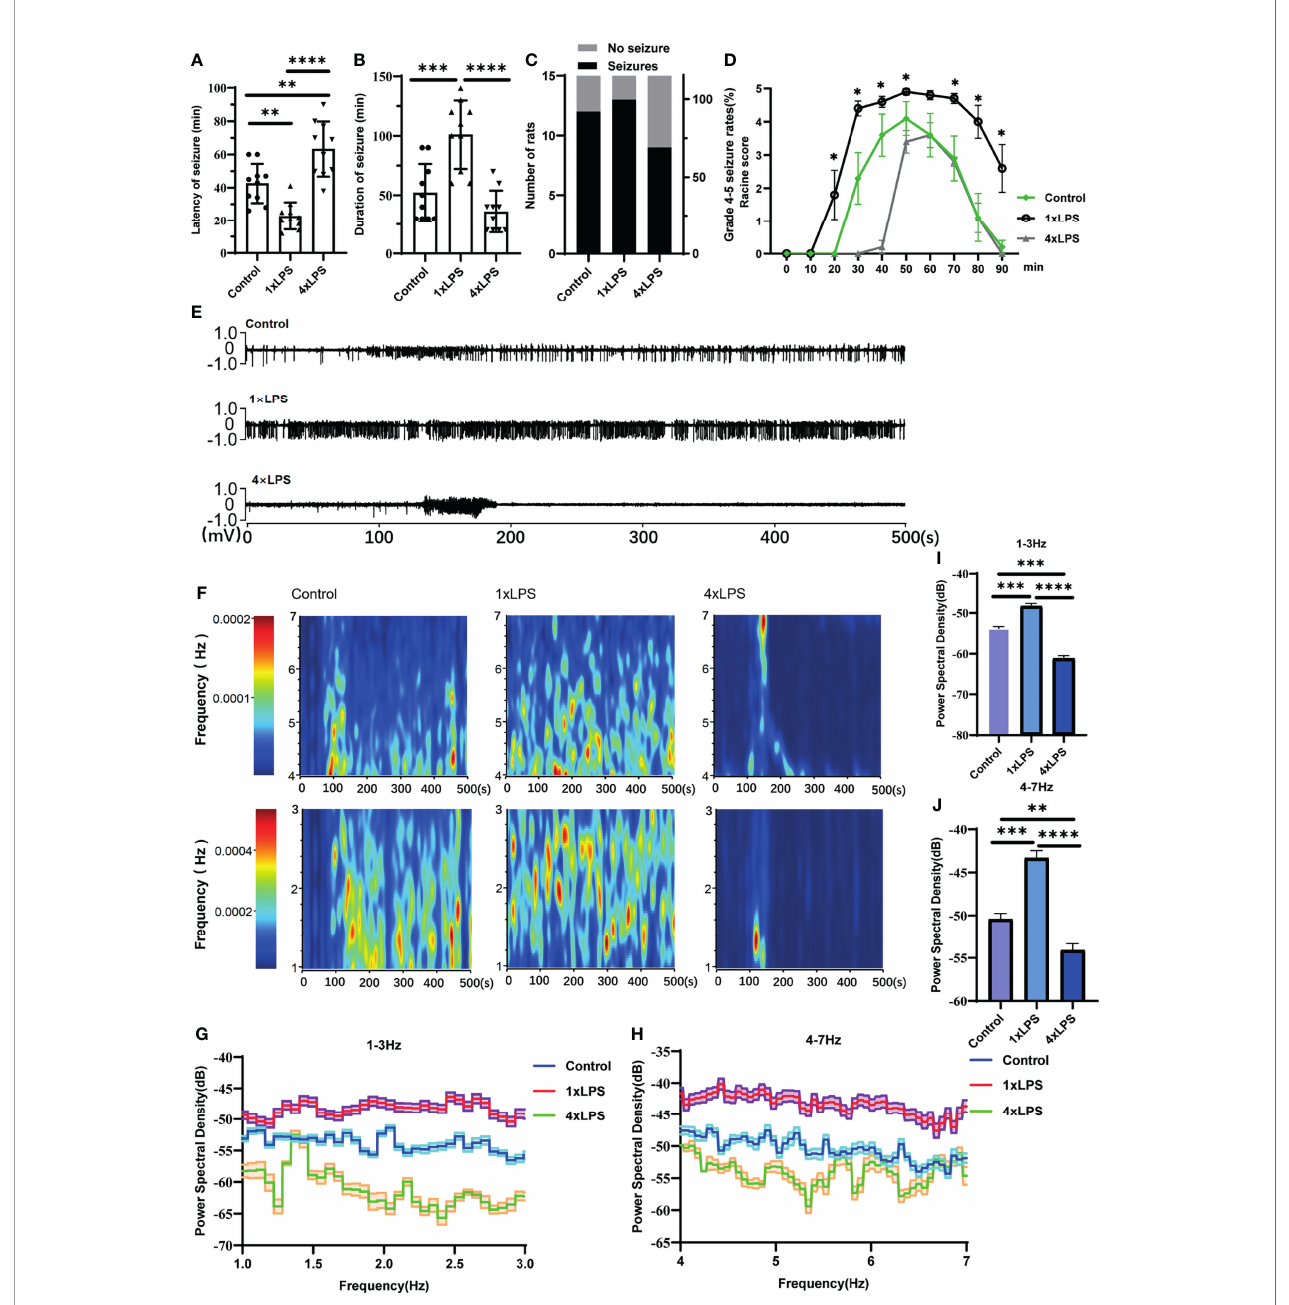
FIGURE 2 | Peripheral immune stimulation modulates epileptic-seizure activity. (A) Immune training (1×LPS) and immune tolerance (4×LPS) on the latency of grade 4 or above epileptic seizures. (B) The duration of epileptic seizures. (C) The proportion of mice with stage 4 or 5 seizures. (D) The Racine score at different time points. (E) Representative traces of in vivo hippocampal electroencephalogram recordings at 1h after kanic acid injection. (F) Corresponding power spectrograms of each group. (G) 1-3Hz Energy spectrum trend curve. (H) 4-7Hz Energy spectrum trend curve. (I) Immune tolerance signi fi cantly reduced the average energy density of 1-3Hz oscillatory activity compared to the control group and immune training (1×LPS) group. (J) Immune tolerance (4×LPS) signi fi cantly reduced the average energy density of 4-7Hz oscillatory activity compared to the control group and immune training (1×LPS) group. *p<0.05; **p < 0.01; ***p < 0.001; ****p < 0.0001 by one-way ANOVA (and nonparametric or mixed) followed by methods of multiple